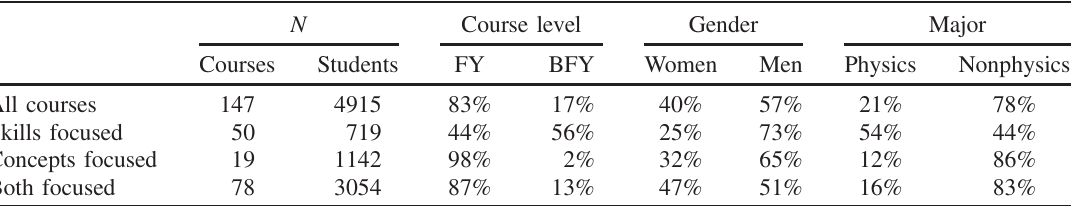
TABLE II. Demographic breakdown of the full data set, as well as the subset of courses with a focus on developing skills, reinforcing concepts, or both. Number of courses refers to the number of separate instances of courses, and percentages represent the percentage of students rather than the percentage of courses. For major and gender demographics, the totals may not sum to 100% as some students did not complete these questions or selected “ other ” as their